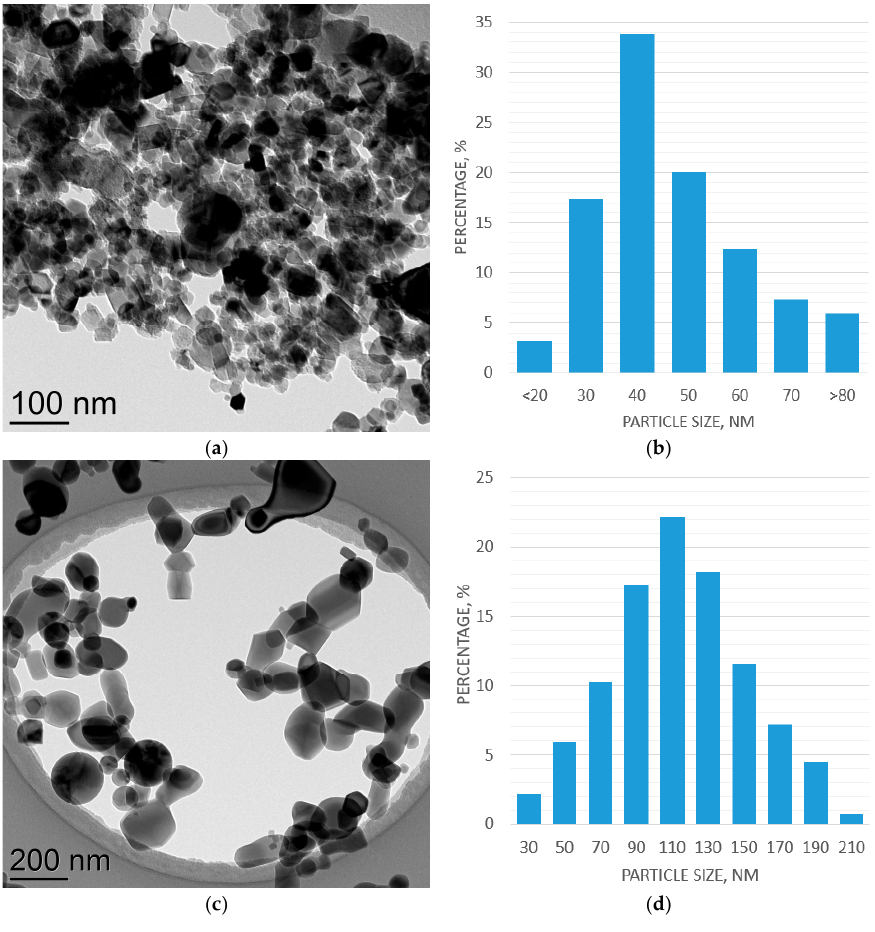
Figure 2. TEM results of the as-synthesized TiO 2 samples. For the d av = 46 nm sample: TEM image ( a ), and size distribution histogram ( b ). For the d av = 100 nm sample: TEM image ( c ), and size distribution histogram ( d ).